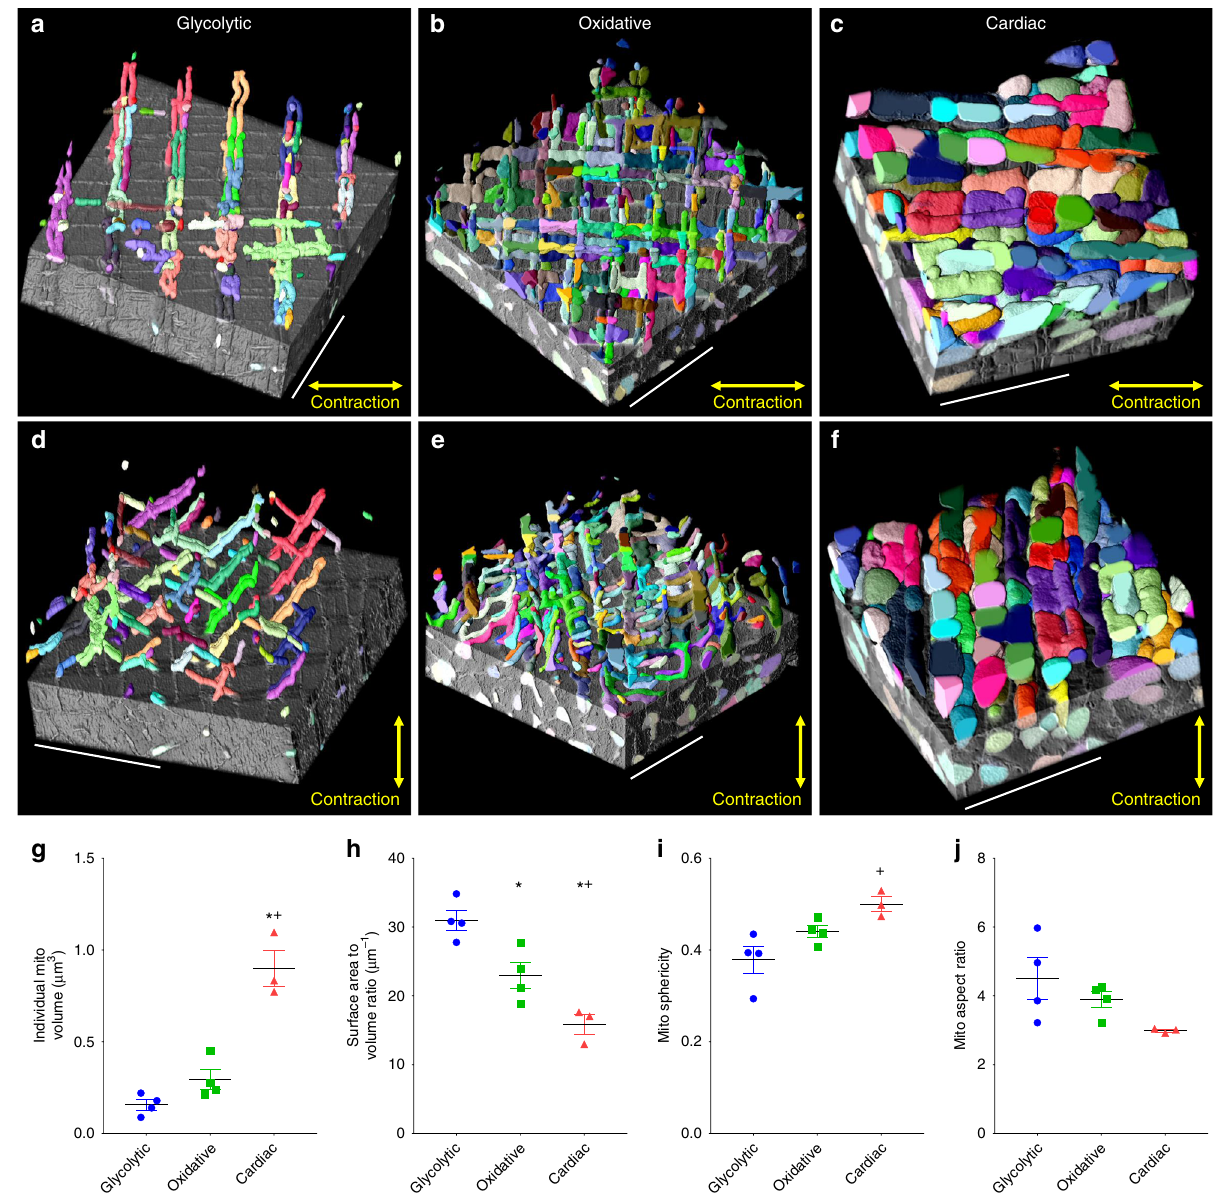
Fig. 2 Individual network components are tuned to meet cellular goals. a 3D rendering of individual glycolytic muscle mitochondria partially overlaid on raw data. Each color represents an individual mitochondrion. b Individual oxidative muscle mitochondria. c Individual cardiac muscle mitochondria. d – f 90° rotation of a – c . g Individual mitochondrial volumes. h Mitochondrial surface area to volume ratios. i Mitochondrial sphericities. j Mitochondrial aspect ratios. glycolytic, n = 1336 mitochondria, 4 datasets; oxidative, n = 2623 mitochondria, 4 datasets; cardiac, n = 1890 mitochondria, 3 datasets. Points are means for each dataset. Bars represent muscle type overall mean ± SE. *Signi fi cantly different from glycolytic, + signi fi cantly different from oxidative. Signi fi cance determined as p < 0.05 from one way ANOVA with Tukey ’ s HSD (variances not different) or Dunn ’ s multiple comparisons (variances different) post hoc tests. Scale bars – 5 µ